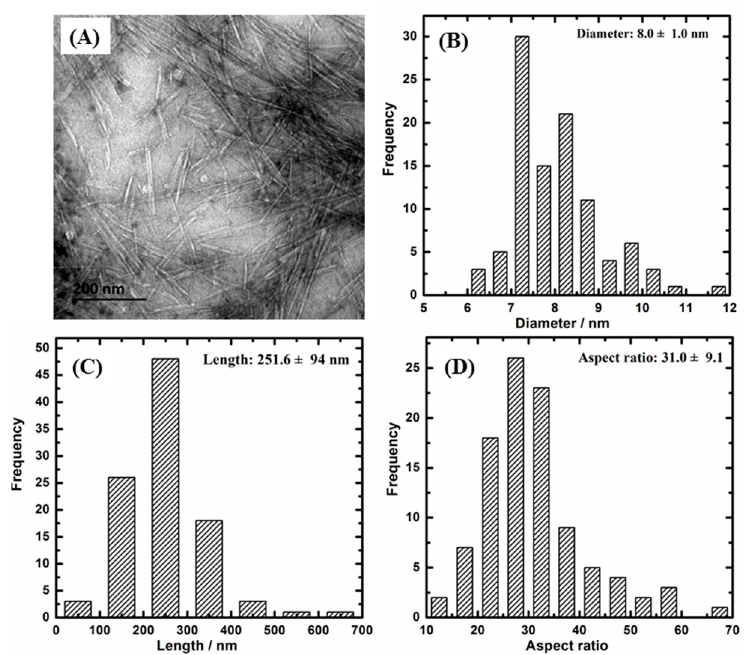
Figure 2. ( A ) TEM image of bacterial CNC (CNC-B) and its size statistics of ( B ) diameter, ( C ) length, and ( D ) aspect ratio.